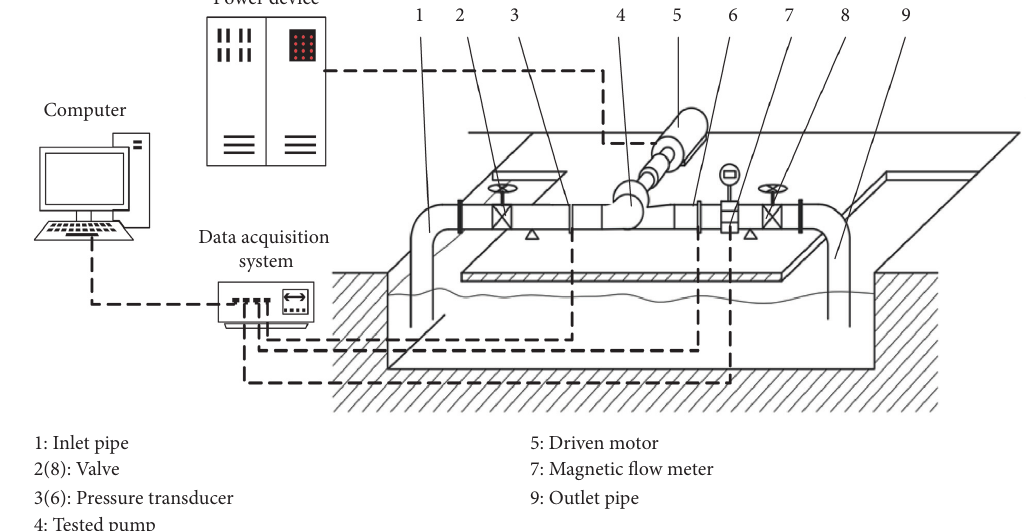
Figure 5: Schematics of the test setup.